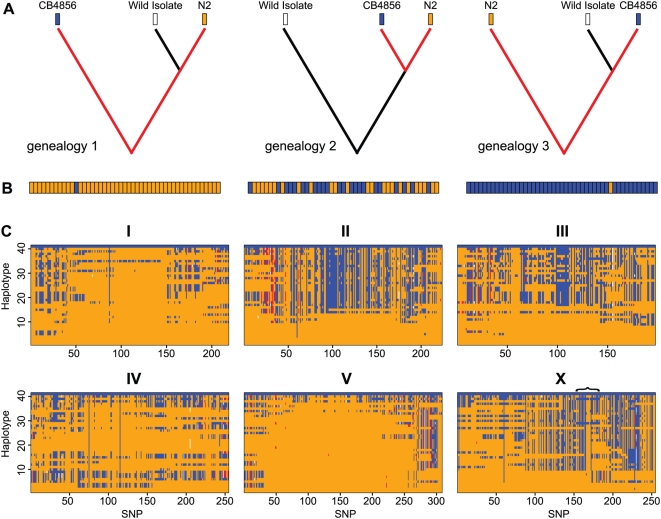
Wild isolate genomes.(A) The effects of SNP ascertainment on haplotypes. All SNPs were ascertained by comparing N2 and CB4856, and must therefore have arisen by mutation on the genealogical branches connecting those two strains. When a third strain is considered, there are three possible genealogies, but all SNP-generating mutations must reside on the ascertained branches, shown in red. The allelic states of the ascertained strains are shown as blue (CB4856) and orange (N2), and the wild isolate allele will be shared with either strain with probabilities that depend on the genealogy. (B) Expected wild isolate haplotypes from each of the genealogies under ascertainment. Typical haplotypes are represented as strings of SNP alleles colored by whether they are identical to N2 or to CB4856. In genealogies 1 and 3, most mutations will fall on the long outgroup branch, and the wild isolate will resemble the strain with which it shares a recent ancestor. In genealogy 2, the two ascertained branches have equal length with respect to the wild isolate, yielding an equal probability of each allele at each position. (C) Haplotypes of wild isolates. Each of the 41 distinguishable haplotypes is represented as a row for each chromosome. N2 carries haplotype 1 (all orange alleles) and CB4856 carries haplotype 41 (all blue). Putative deletions are red. The bracket above the X chromosome labels the interval across which haplotypes 29 and 39 exhibit haplotypes consistent with genealogy 3.